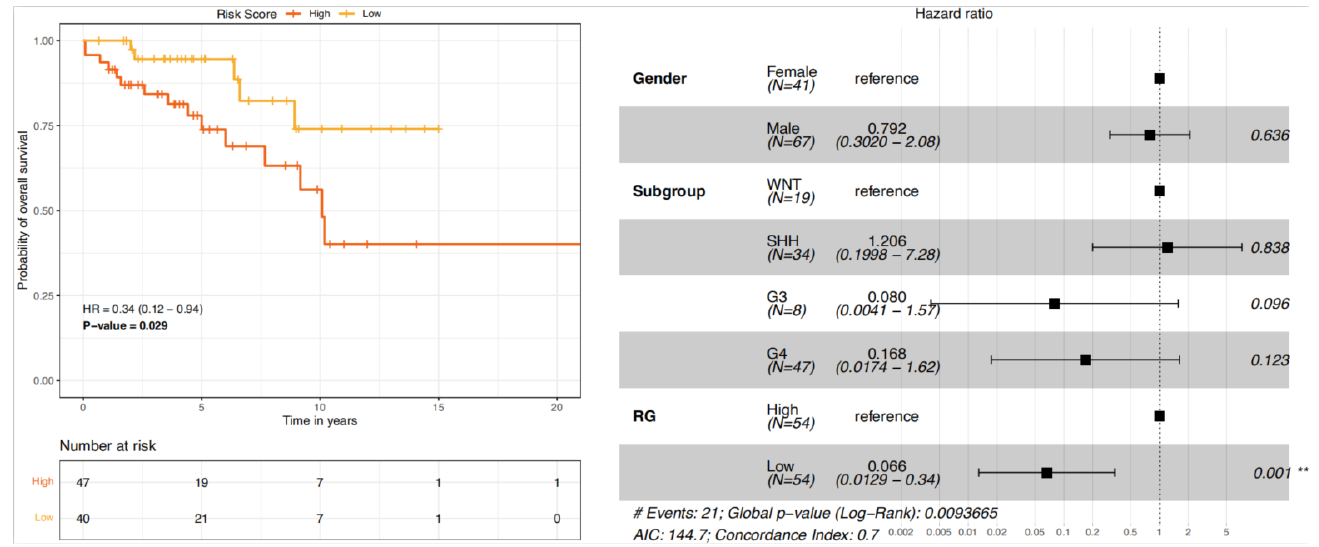
Figure 6. Evaluation of a prognostic gene expression signature for TYAs with medulloblastoma. OS curves of TYA patients with a low- or high-risk of death, according to a combined prognosis score derived from a LASSO analysis. Shown are Kaplan–Meier curves ( left ) of overall survival in TYA patients with low- or high-risk of death. The hazard ratio (HR) and 95% confidence interval of gender, MB subgroups, and risk score were calculated by multivariate regression analysis. The factor in the analysis could be considered as an independent prognostic factor when p value was <0.05 ( right ). ** indicates the p value cut-off at